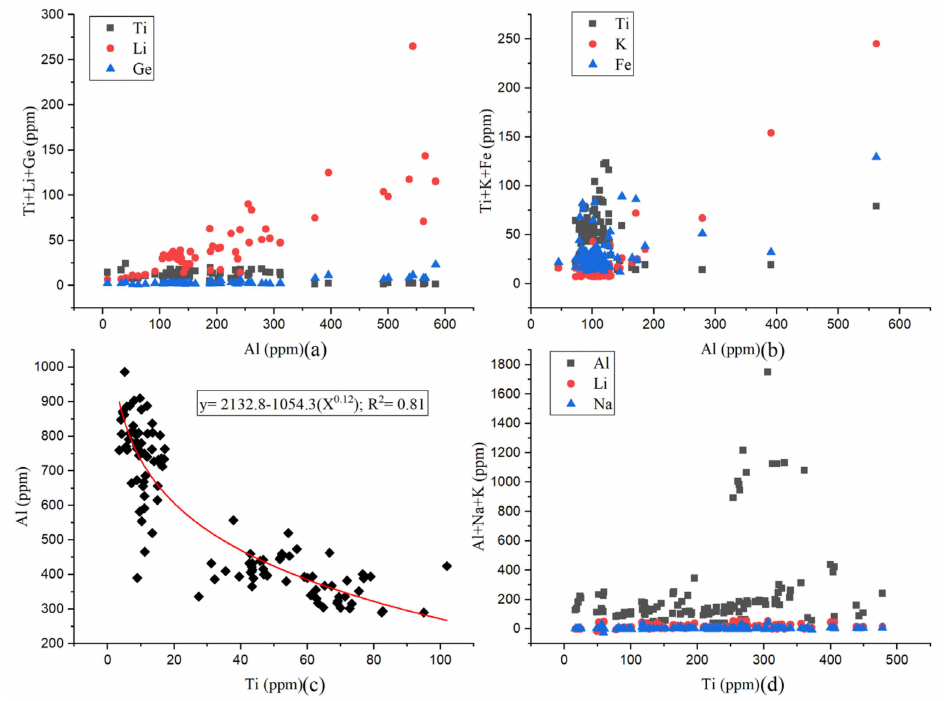
Figure 8. ( a ) A demonstration of the relationship between Al and other trace elements. The data were collected from [7,27,78]. Li is the only element that strongly correlates with Al. ( b ) Relationships between Al vs. Ti, K, and Fe. The data were collected from the eastern Erzgebirge volcano-plutonic complex in Germany [78]. ( c ) Magmatic quartz Al vs. Ti relation, both having an inverse relation. ( d ) Relationship between Ti vs. Al, Li, and Na. The data were collected from